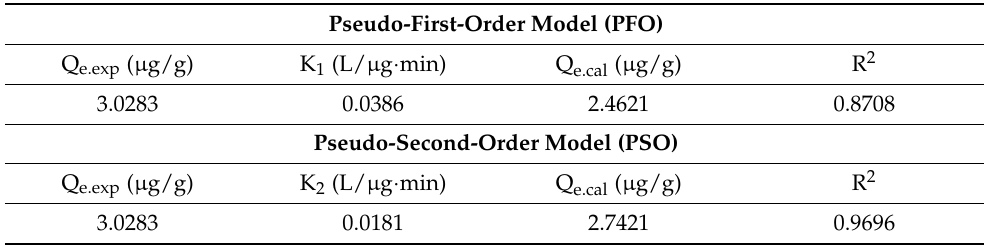
Table 2. Pseudo-first-order and pseudo-second-order kinetic parameter model for the adsorption of As(III) onto the combination of GO (0.2 g/L) and GFH (0.1 g/L), pH 7.0 ± 0.1, dosage 2 g/L, Figure 7. Kinetic models of pseudo-first and pseudo-second order for the adsorption of As(III) onto T = 298 K, contact time 24 h, in deionized the combinatio n of GO (0.2 g/L) and GFH (0.1 g/L); initial As(III) concentration 100 μg/L, pH 7. 0 ± 0.1, T = 298 K, in deionized water.